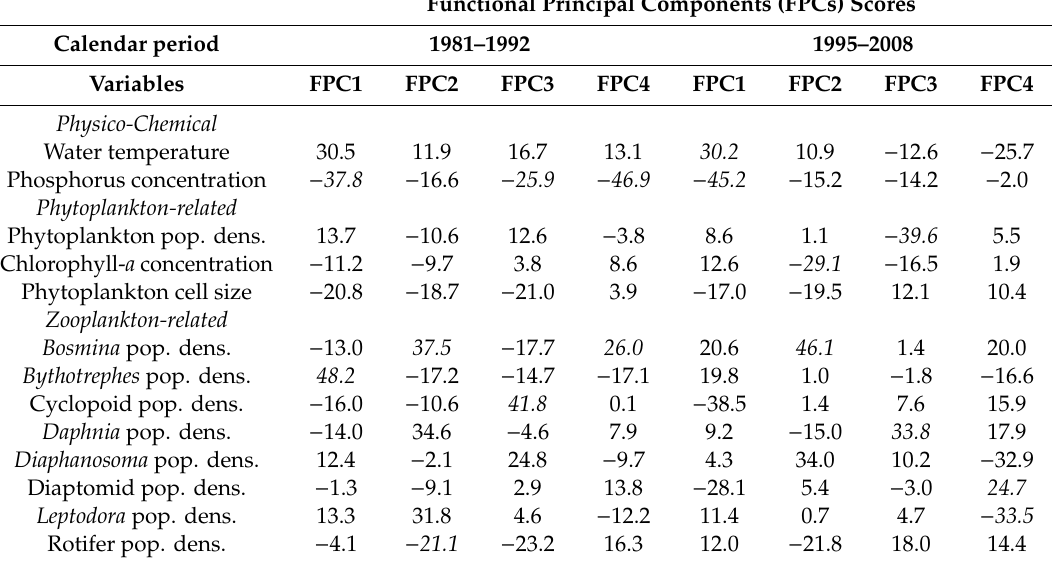
Table 1. Functional Principal Components (FPCs) scores for three different groups (in italics) of considered variables. The most extreme positive and negative scores are highlighted (italics) for each FPC. Pop. dens. = population density.